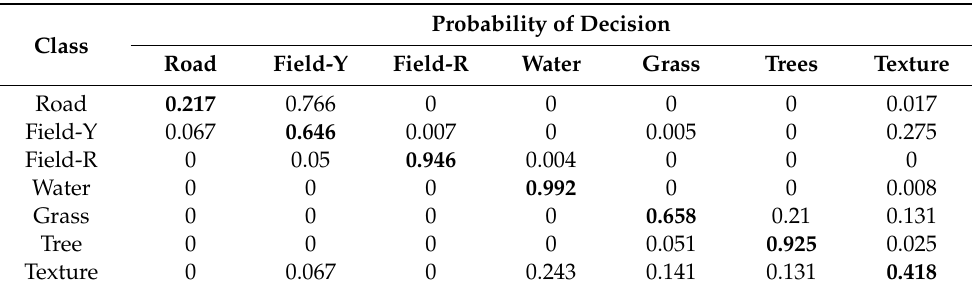
Table 9. Confusion matrix for compressed image classified by NN trained for the original image and applied for the compressed image (PSNR-HVS-M = 30